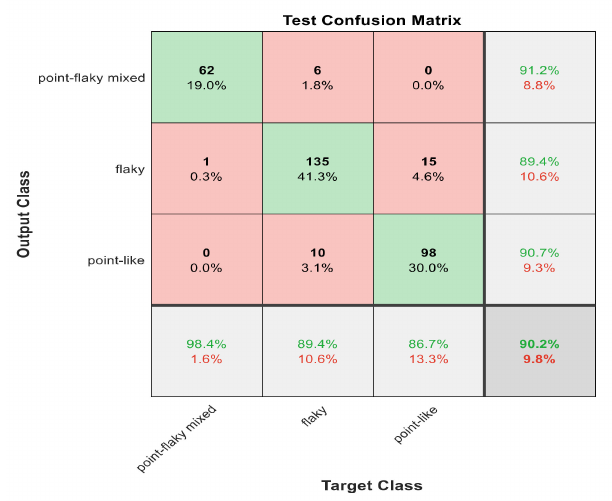
Figure 20. The confusion matrix for whole cascading system using 1000 deep learning features.